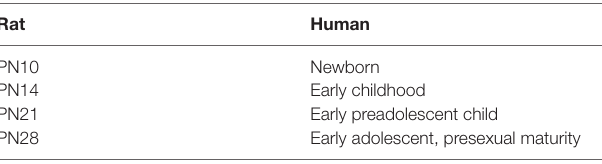
Table 2 | rough age equivalents between rats and humans. rat human PN10 Newborn PN14 Early childhood PN21 Early preadolescent child PN28 Early adolescent, presexual